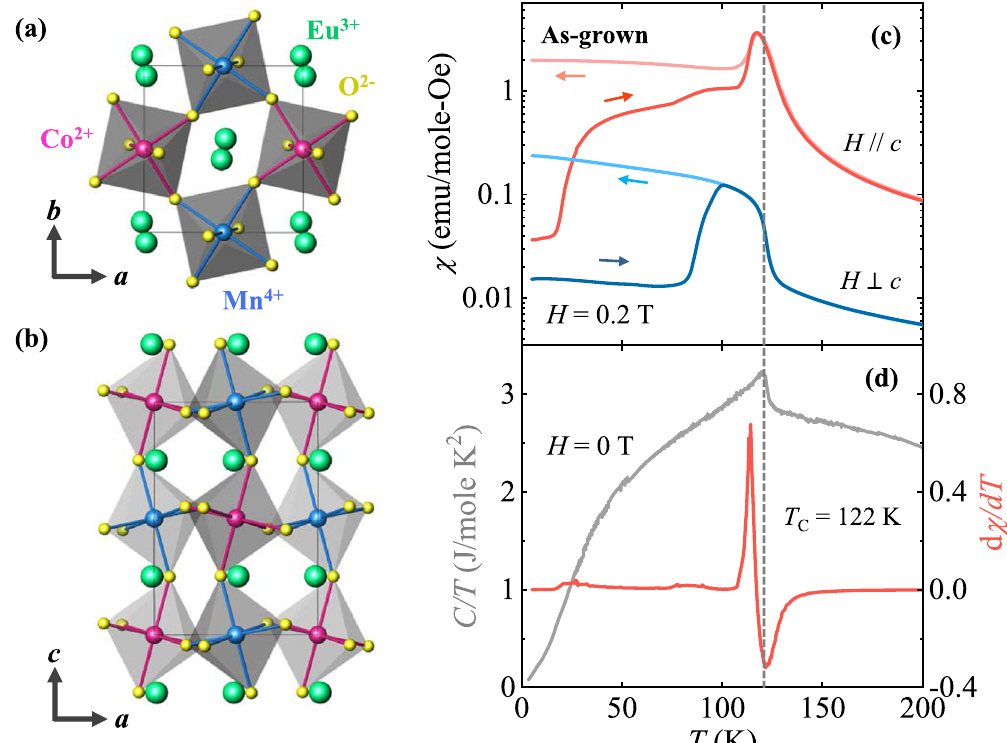
Figure 1. Crystallographic structure and temperature dependence of magnetic susceptibility in as-grown crystal. Views of the crystallographic structure of double-perovskite ECMO from the ( a ) c and ( b ) b axes. The green, pink, blue, and yellow spheres represent Eu 3+ , Co 2+ , Mn 4+ , and O 2− ions, respectively. ( c ) Temperature dependence of magnetic susceptibility, χ = M/H , shown in log scale, for the as-grown crystal in H = 0.2 T along and perpendicular to the crystallographic c axis and upon warming after ZFC and cooling in the same H (FC). The dotted line indicates the Curie temperature of T C = 122 K. ( d ) Temperature derivative of ZFC χ along the c axis in H = 0.2 T and temperature dependence of specific heat divided by the temperature, C/T , measured in zero H